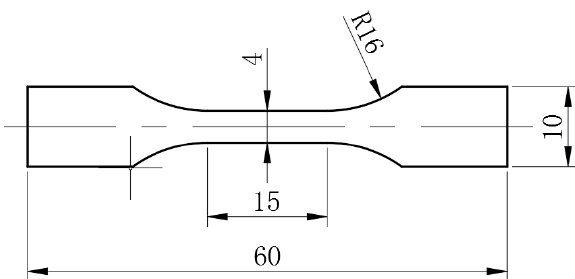
Figure 2. Shape and dimensions of tensile specimens (all dimensions in mm).